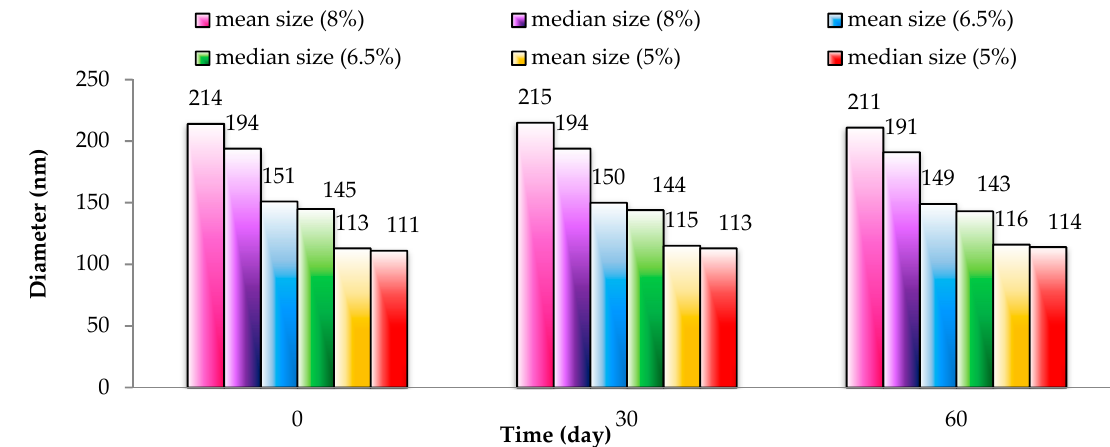
Figure 8. Changes in particle size by the time storage of 5%, 6.5% and 8% gac-oil.